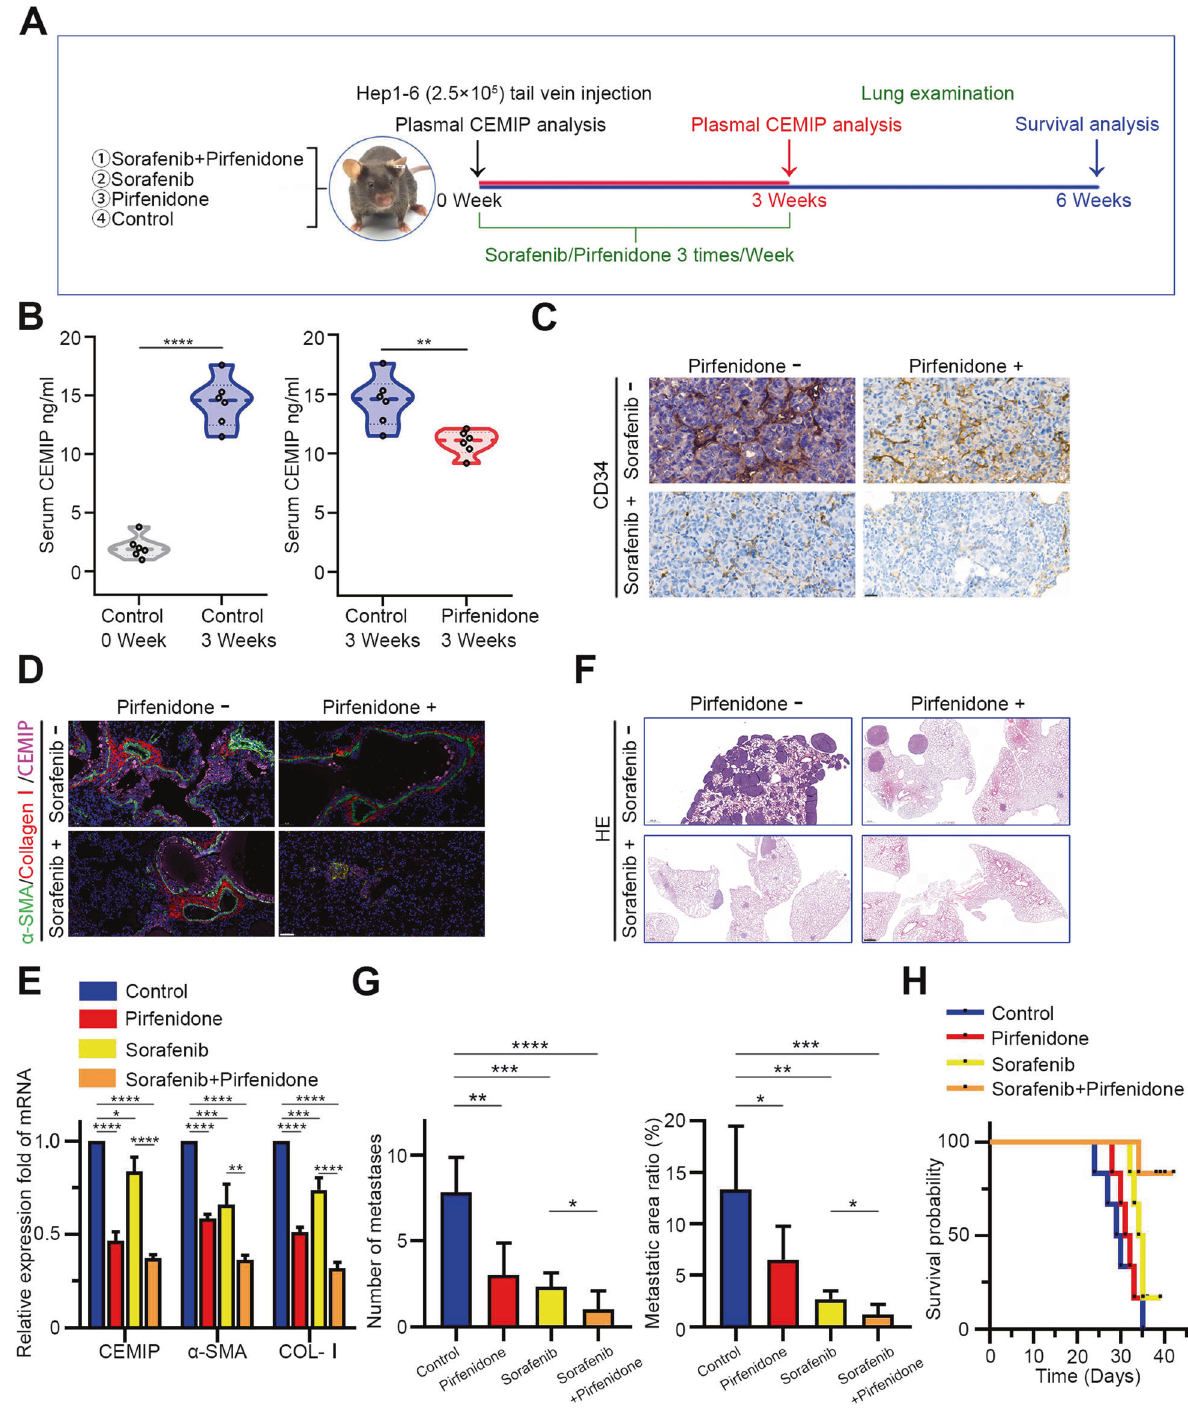
Fig. 6 The combination of pirfenidone and sorafenib suppresses metastatic angiogenesis and prolongs survival. A Schematic of the animal experiments conducted using C57BL/6J mice. B Left : Plasma CEMIP levels of mice exhibiting lung metastasis and control mice. Right : Plasma CEMIP levels of pirfenidone-naive and pirfenidone-treated mice. C CD34 expression in paraf fi n sections of metastasized foci. Scale bar = 20 μ m. D Immunostaining of COL-I (red), α -SMA (green), and CEMIP (pink) on lung tissues adjacent to the metastasized foci. Scale bar = 50 μ m. E The expression of stiffness-associated markers expressed in lung sections obtained from 4-week-old mice in different treatment groups was determined by qRT-PCR analysis. F , G Comparison of metastatic colony number and area in the lungs of mice at week 4. Scale bar = 500 μ m. H Kaplan – Meier curves of cumulative overall survival in mice receiving different therapies.